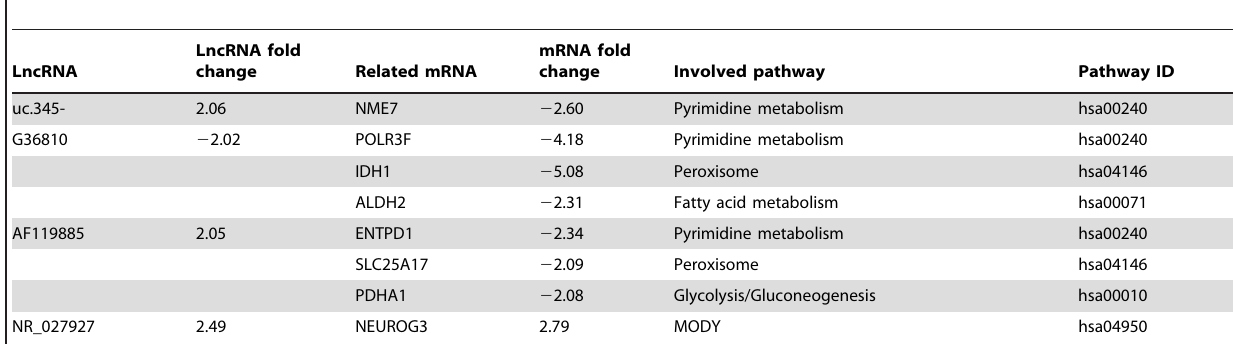
Table 7. Interactional lncRNAs-mRNAs detected from significantly different expressed lncRNAs and mRNAs.